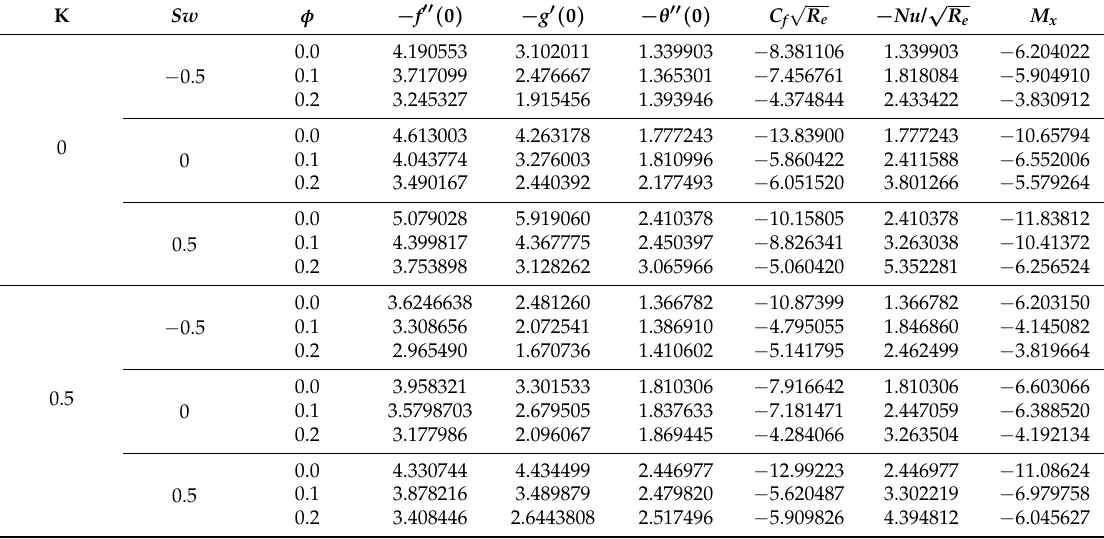
Table 4. Values of − f (cid:48)(cid:48) ( 0 ) , − g (cid:48) ( 0 ) , and − θ (cid:48) ( 0 ) for the unsteady case [ A = 1] at R = 1, Pr = 6.2, M = 0.1, kp =